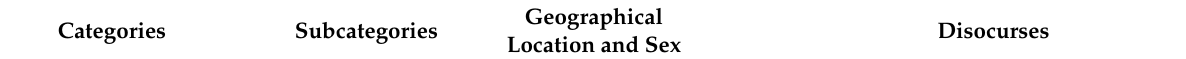
Table 3. Use of personal and intimate spaces in relation to other spaces or social media tools.